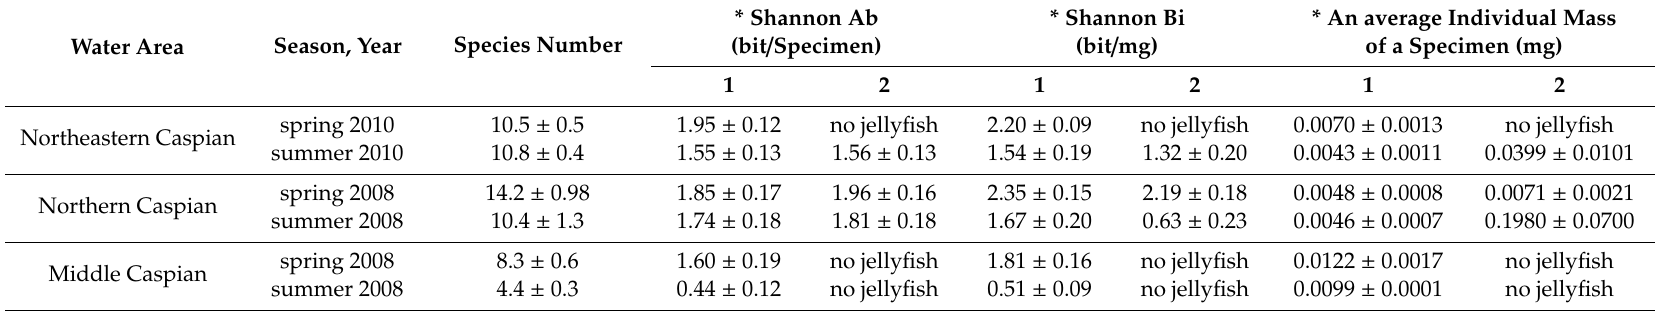
Table 5. Structural variables of zooplankton communities in the surveyed water area of the Caspian Sea (mean with standard error).